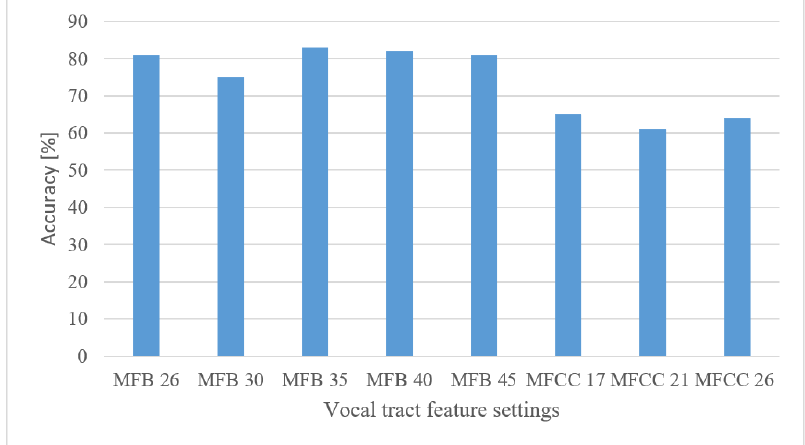
Figure 14. Accuracies for 26, 30, 35, 40, and 45 MFBs, and 17, 21, and 26 MFCC coefficients.